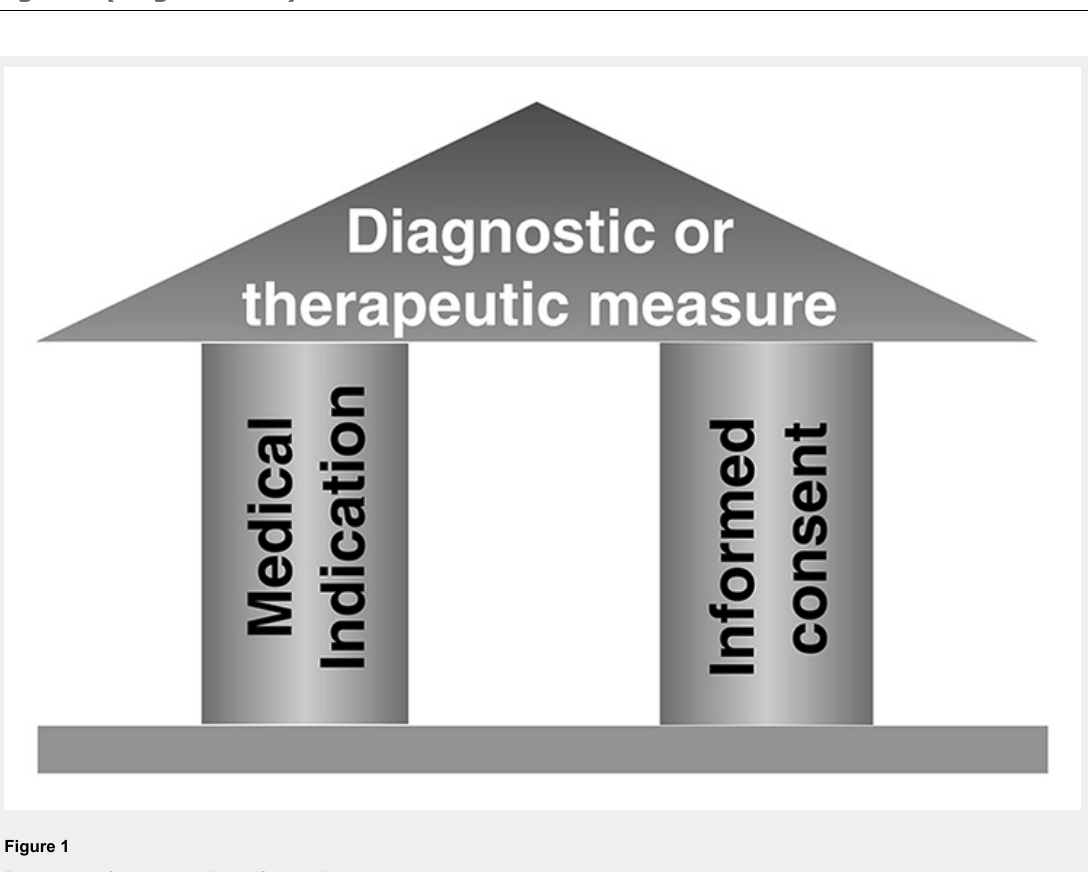
Prerequisites for any ethically justified medical